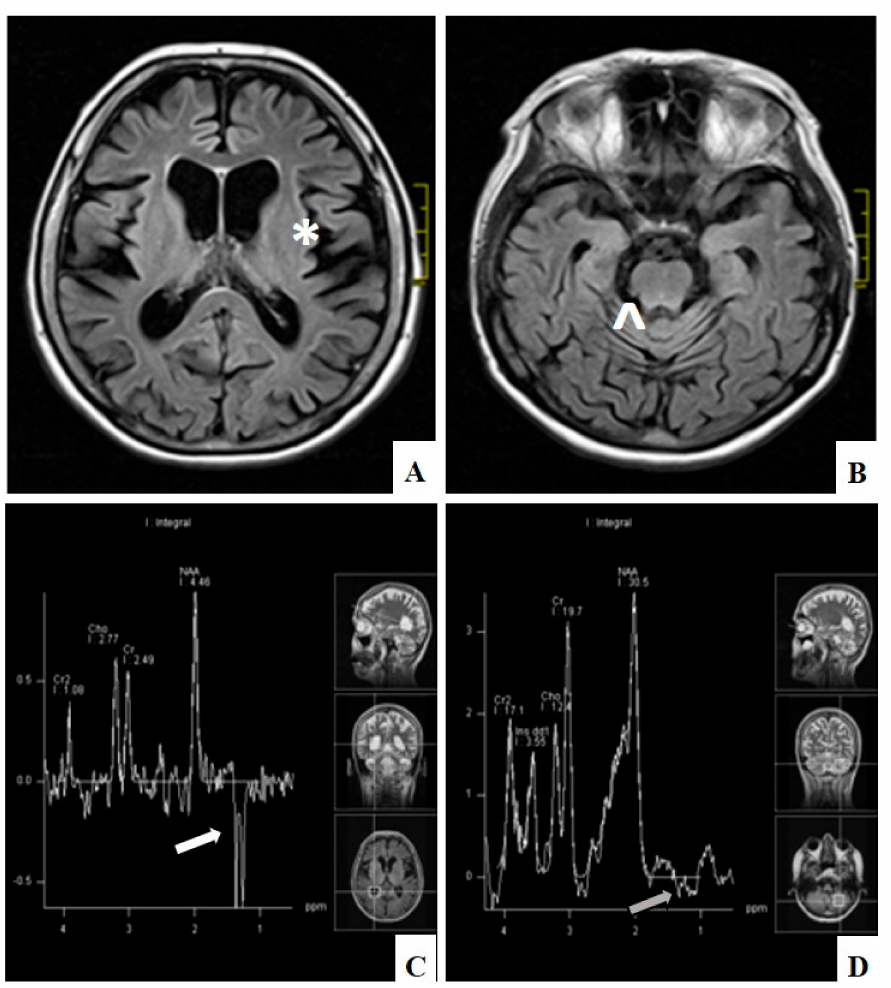
Figure 3. Diffuse cerebral (*) (A) and cerebellar atrophy (ˆ) (B) on MRI, FLAIR and lactate peak) in the lateral ventricle (white arrow) (C) and normal level in the cerebellum (grey arrow) (D) on MRI spectroscopy in patient with ME (patient number